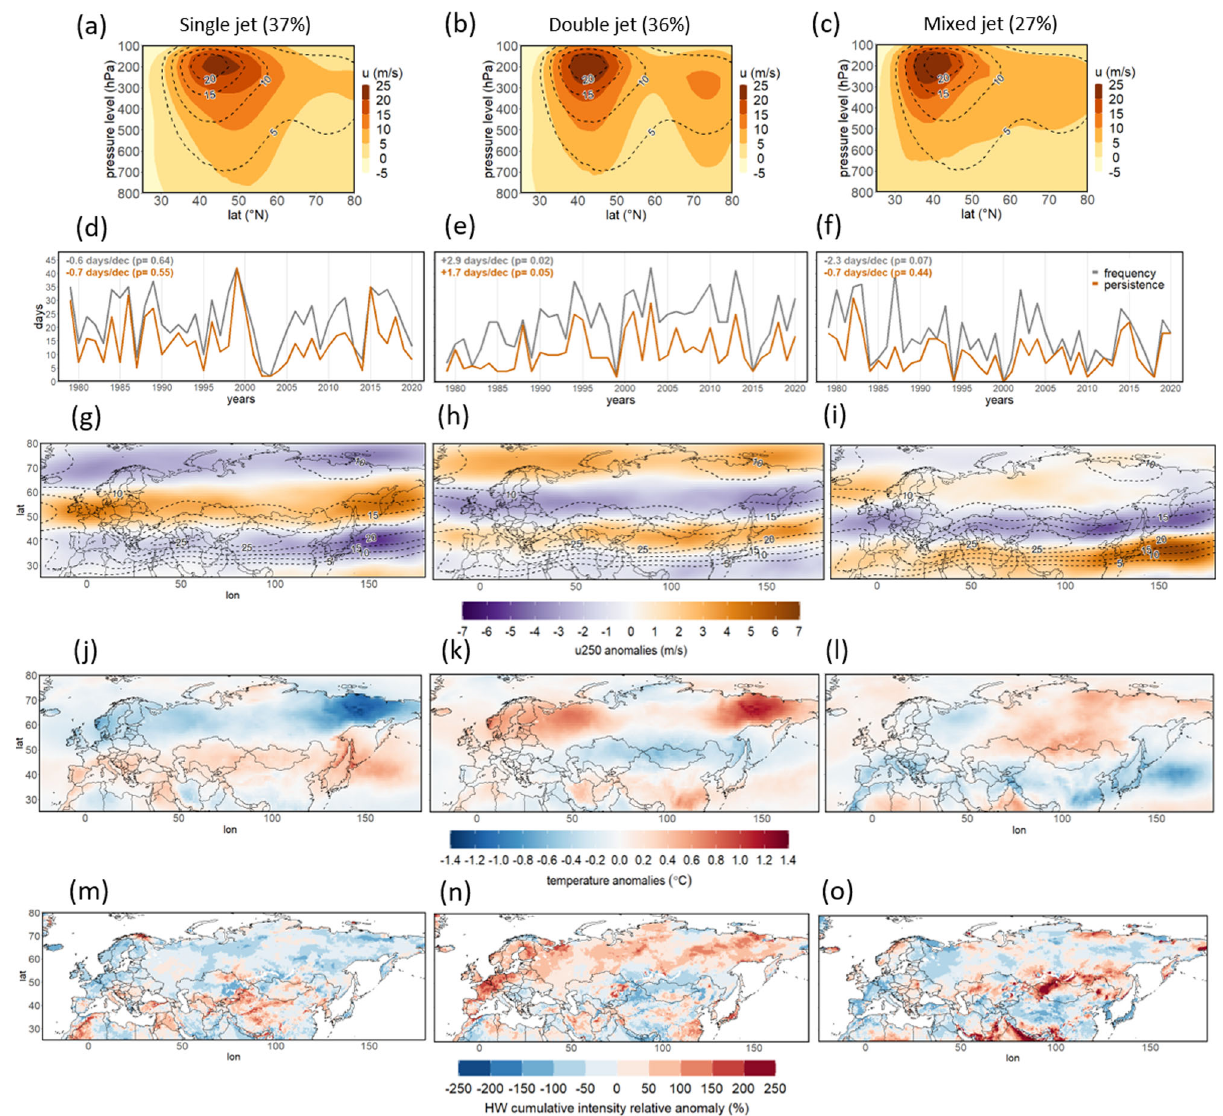
Fig. 2 Jet stream states and surface temperature. a – c Clusters of the vertical pro fi le of the zonal (averaged over the Eurasian domain) mean zonal wind (u, shading) with frequency of occurrence provided in parenthesis. The climatological mean of the zonal mean zonal wind for the whole period is plotted with dashed contours (plotted from 5 to 20 m/s every 5 m/s). d – f Frequency (gray line) and maximum persistence (orange line) of each cluster per year. The decadal linear trend and respective p-values are given for both time series on the top left of the panels. g – i Anomaly composites of (linearly detrended) zonal wind at the 250hPa pressure level (u250) for each cluster (shading). The climatological mean of the zonal wind at 250hPa is plotted with dashed contours (plotted from 5 to 25 m/s every 5 m/s). j – l Anomaly composites of (linearly detrended) mean surface temperature for each cluster. Anomalies in both cases are calculated with respect to daily climatology (to remove the seasonal cycle). m – o Composites of heatwave cumulative intensity (calculated after having removed the Tmax mean midlatitude-land trend from each grid point) shown as relative anomaly (%) compared to the climatology. All fi